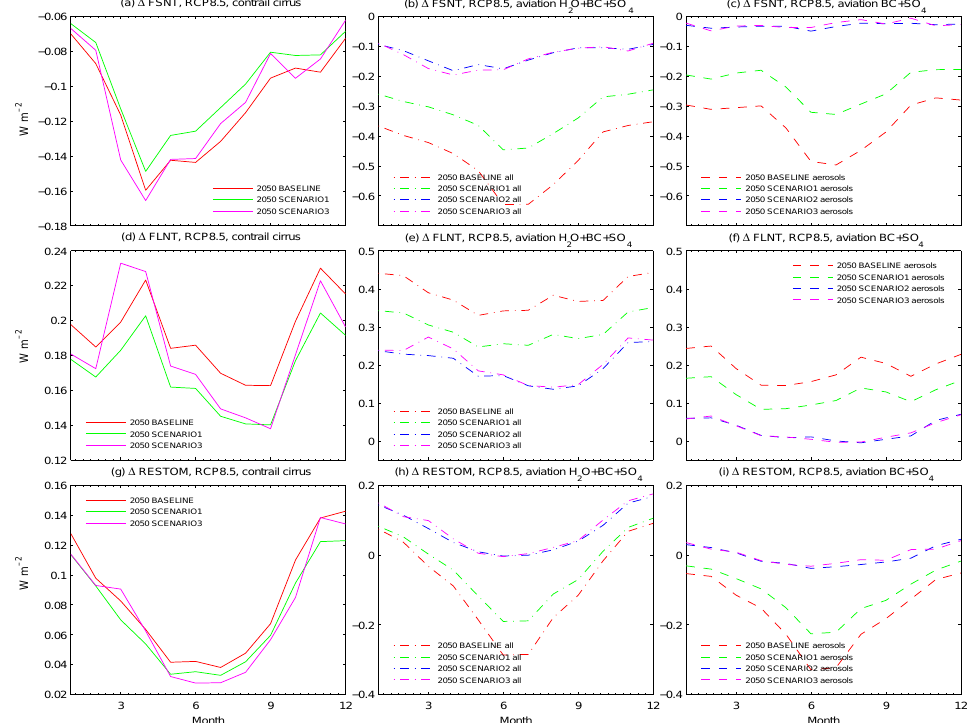
Figure 7. Annual cycle of globally averaged shortwave (FSNT: a–c ), longwave (FLNT: d–f ) and net (RESTOM: g–i ) radiative forcing in Wm − 2 at the top of the atmosphere due to contrail cirrus (a, d, g) , contrail cirrus and aviation aerosols (b, e, h) and aviation aerosols (c, f, i) based on three aviation emission scenarios in 2050 with RCP8.5 2050 meteorology.